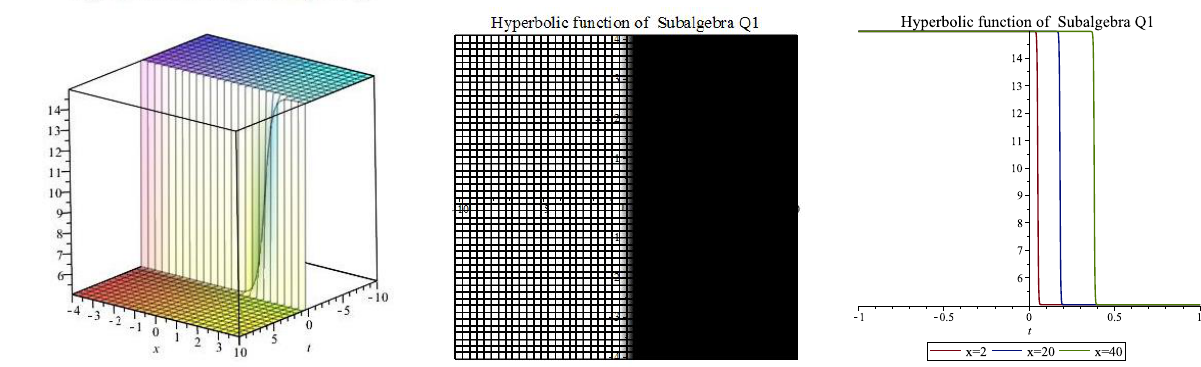
Figure 2. Solitary wave depiction of topological anti-kink soliton (36) at y = 0.